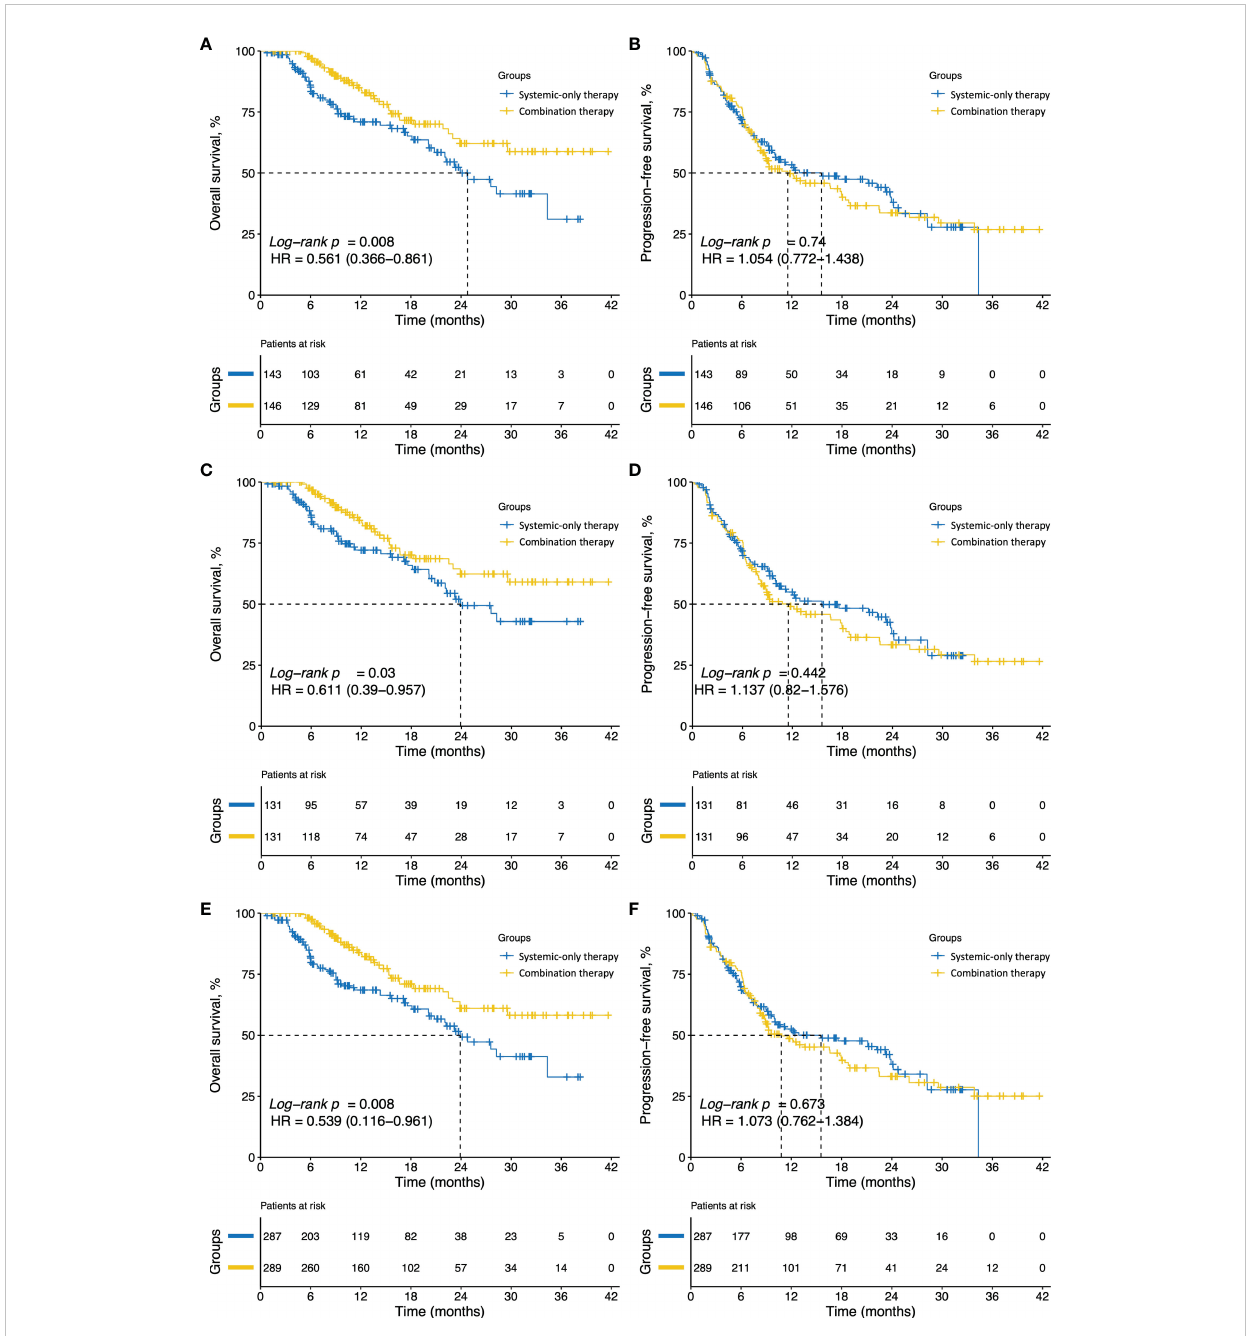
FIGURE 2 Kaplan – Meier curves of overall survival (OS) and progression-free survival (PFS) for patients in the different groups. (A) OS and (B) PFS of patients in the systemic-only group ( N = 143) or combination group ( N = 146) before PSM. (C) OS and (D) PFS for the systemic-only group ( N = 131) and combination group ( N = 131) after PSM. (E) OS and (F) PFS for patients in the systemic-only group ( N = 287.37) and combination group ( N = 289.04) weighted by IPTW. HR, hazard ratio; PSM, propensity score matching; IPTW, inverse probability of treatment